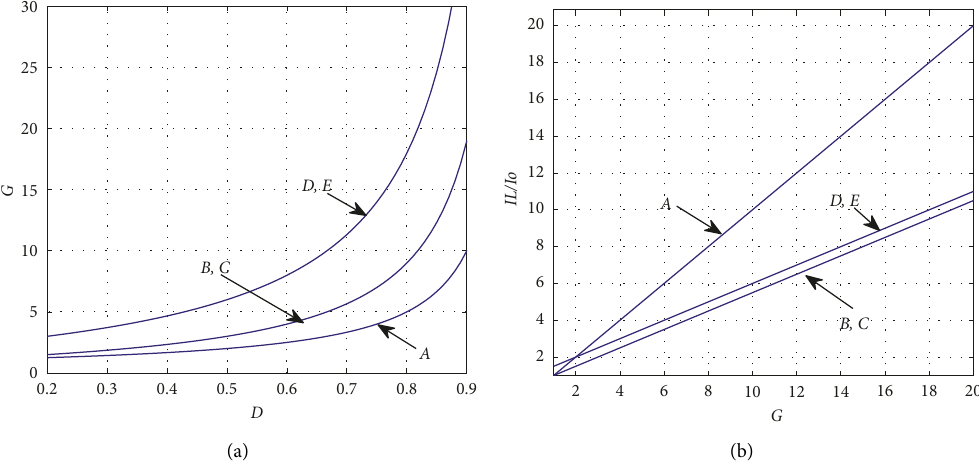
Figure 7: Comparison. (a) Voltage gain G versus duty cycle D. (b) The ratio of inductor current IL to output current Io versus duty cycle D. Note: A represents boost converter [4], B represents SIBC [16], C represents converter [19], D represents converter [20], and E represents the proposed DS-HS converter.